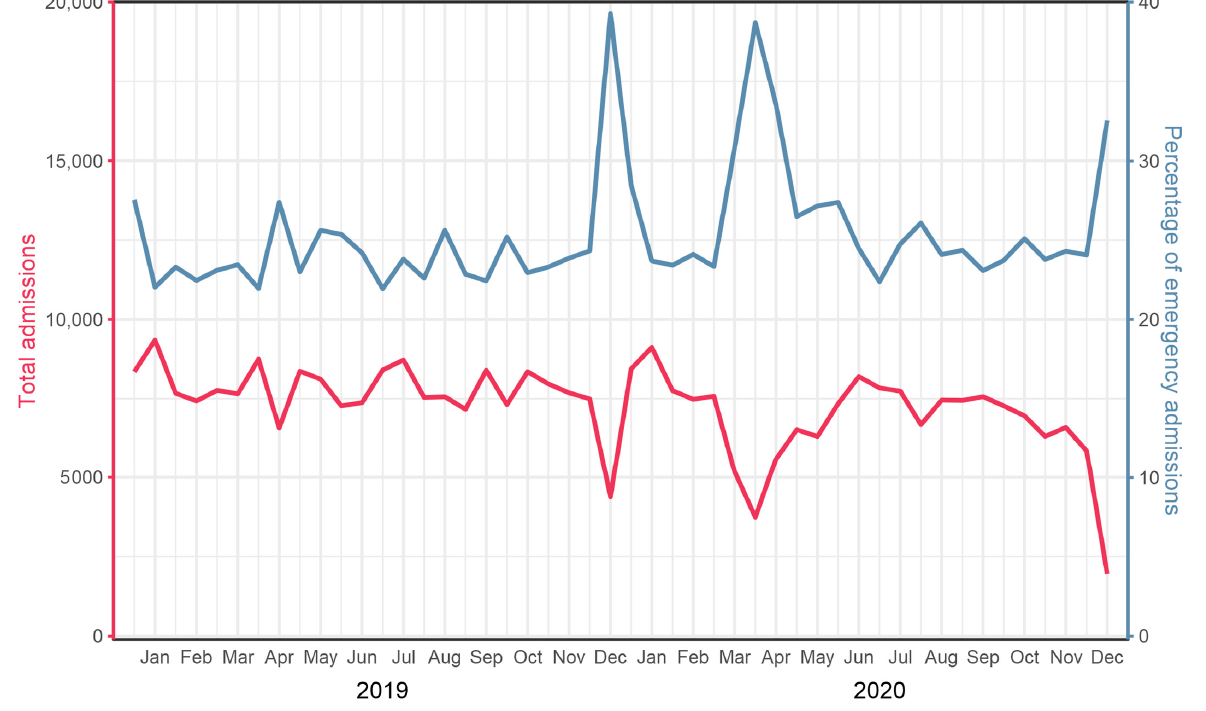
Figure 1. Semi-monthly numbers of total PAD admissions (red line) and percentage of emergency admissions (blue line) in Germany in 2019 and 2020.